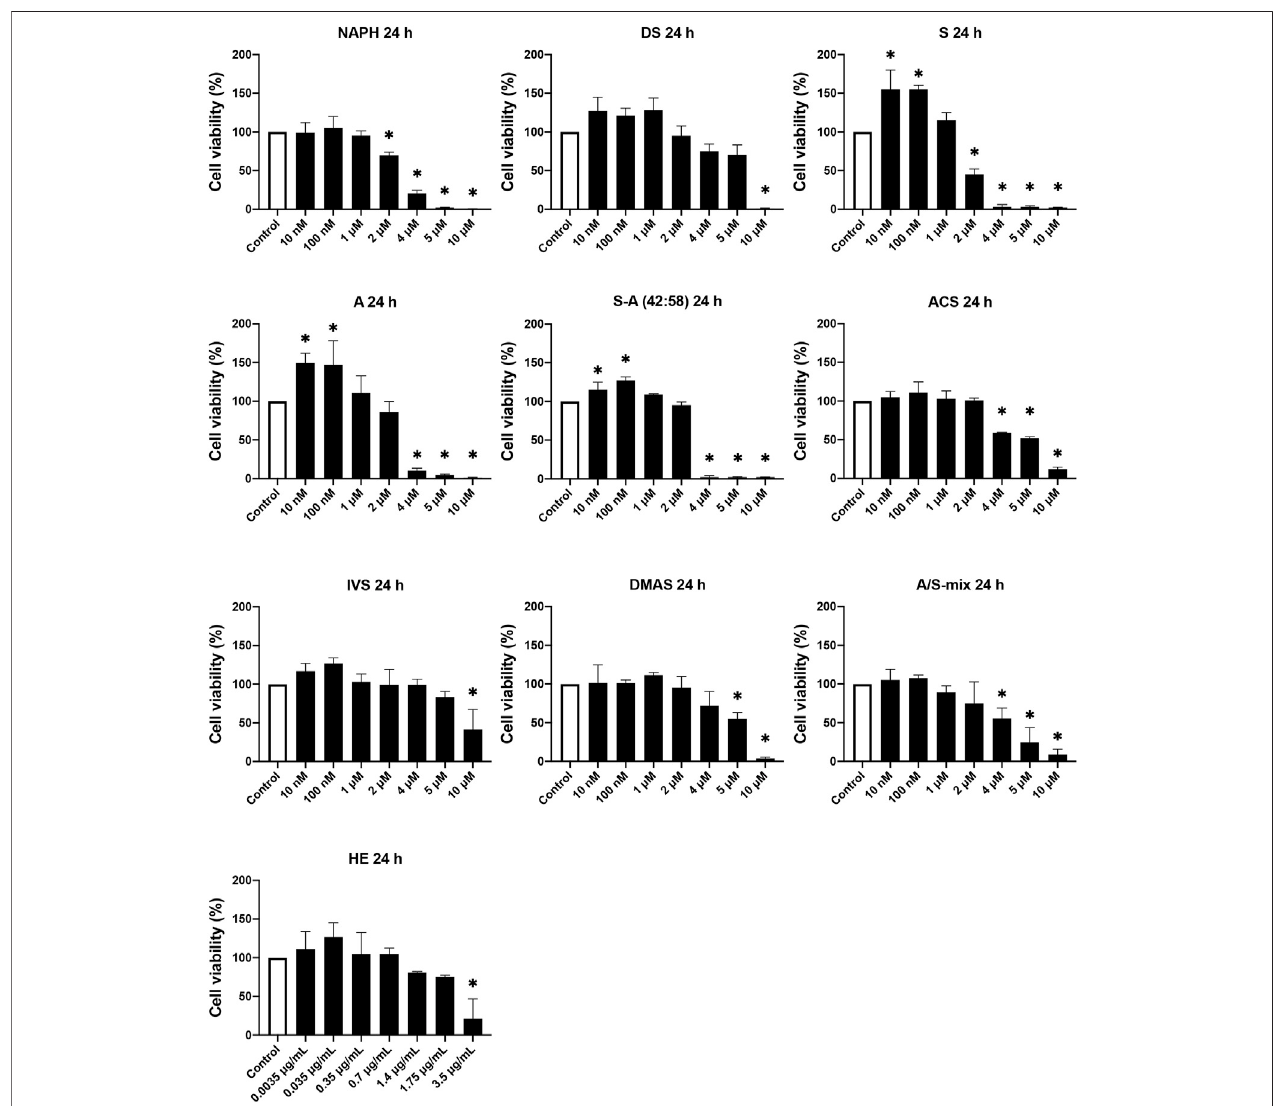
FIGURE1| Cellviabilityof3T3-L1pre-adipocytecellsupontreatmentwithvariousA/Sderivativesat24 h*indicates p < 0.05comparedtountreated(control)cells. Cell viability values are expressed as the percentage of viability observed in untreated cells (100% cell viability). Data are shown as the mean of three individual experiments